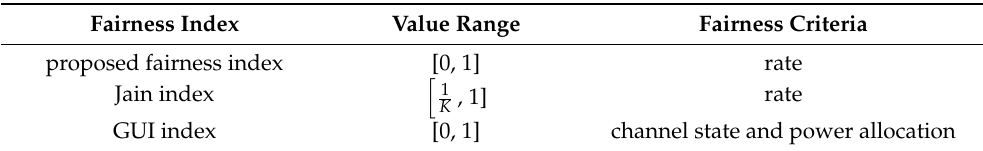
Table 1. Comparison of our proposed fairness index with other